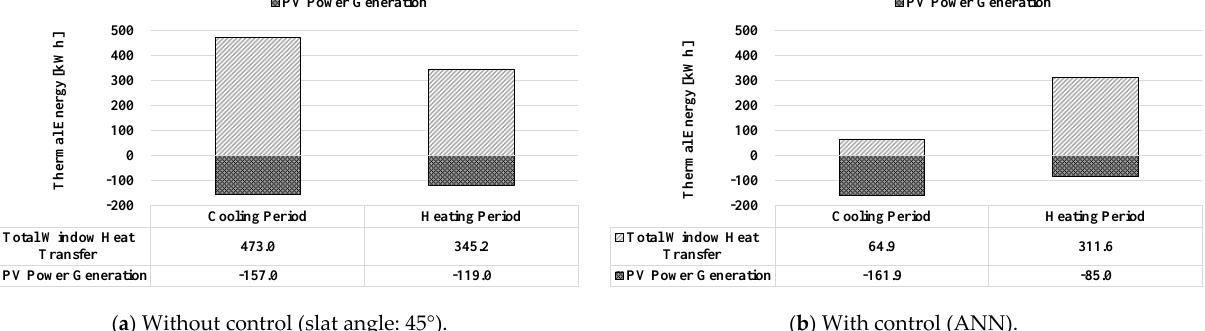
control. In this figure, PV power generation is indicated by negative (−) numbers to indi- cate decreased window heat transfer.